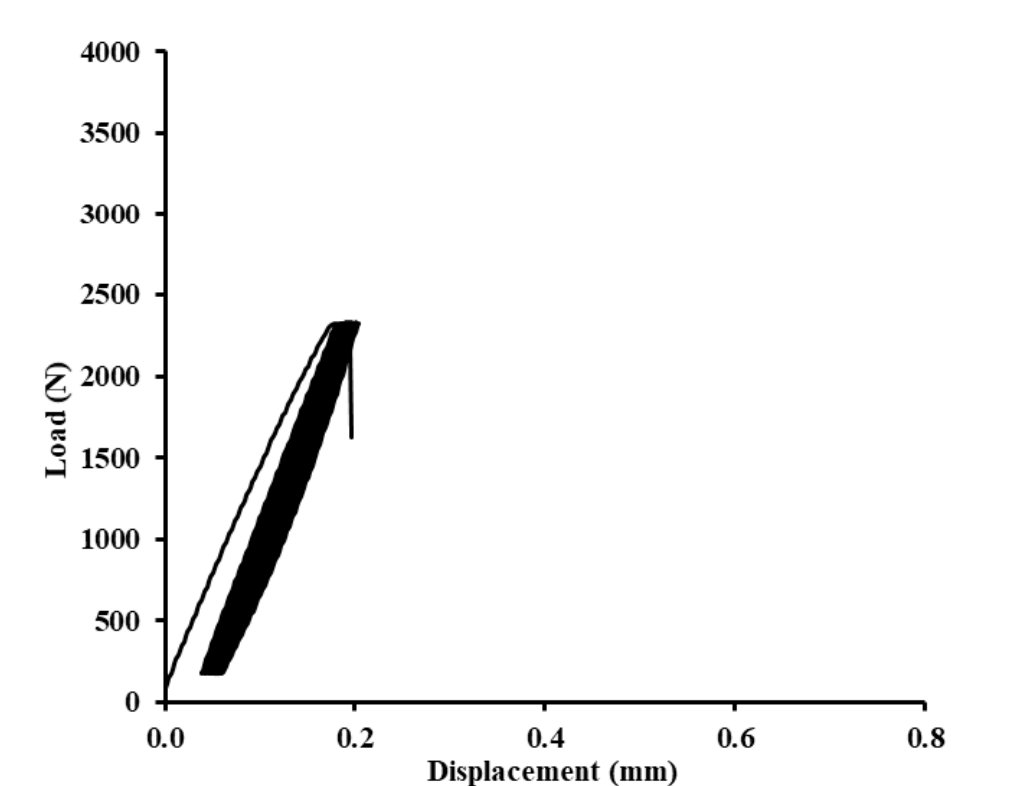
Figure 10. Quasi-static graph of adhesive bond ABFE0 with loading 5–30% (165–989 N)—1000 cycles.